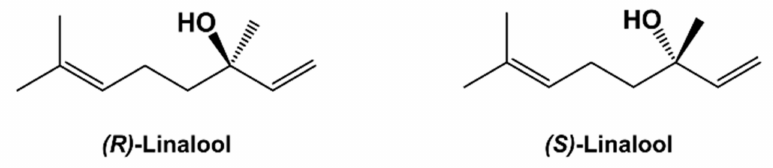
Figure 1. Chemical structure of linalool (( R )- and ( S )-enantiomers).